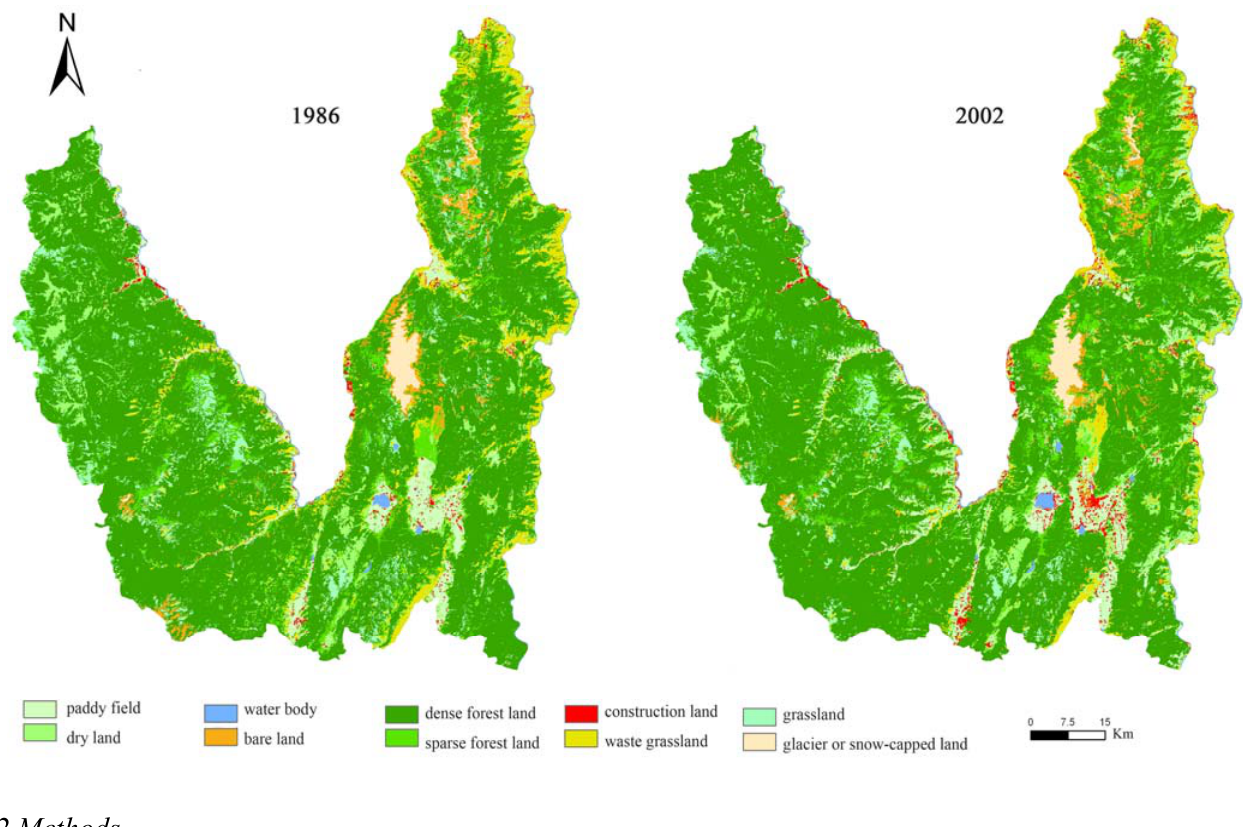
Figure 3. The classification maps of land use in Lijiang County in 1986 and